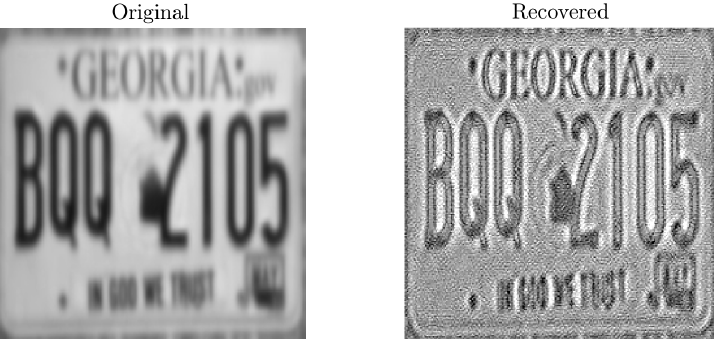
Figure 22. Further result on deblurring an image that does belong to a training set obtained by reshuffling the data set.